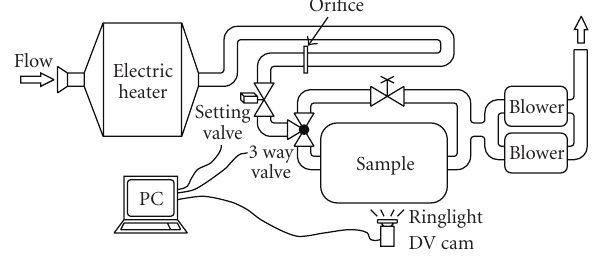
Figure 1: Experimental